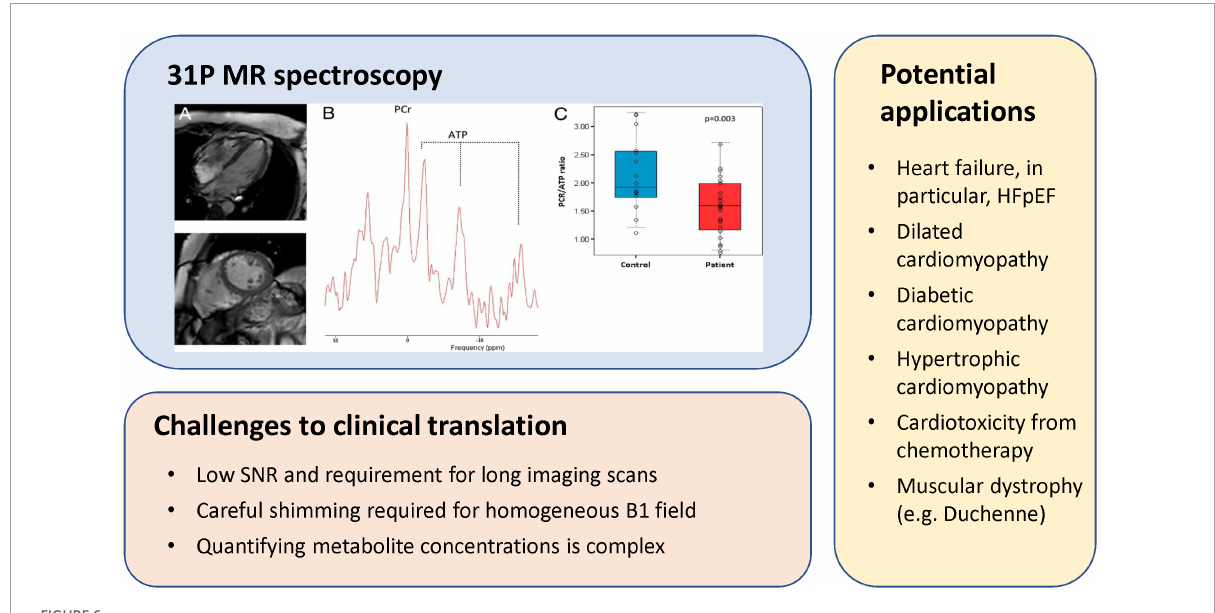
FIGURE6 31P MR spectroscopy of myocardial energetics, challenges, and potential applications. (Upper left panel) CMR images of a patient with heart failure with preserved ejection fraction (HFpEF), corresponding localized 31P MR spectra from the left ventricle, and individual PCr/gamma-ATP ratio in patients with HFpEF and in control subjects [this research was originally published in Phan et al. (48)].